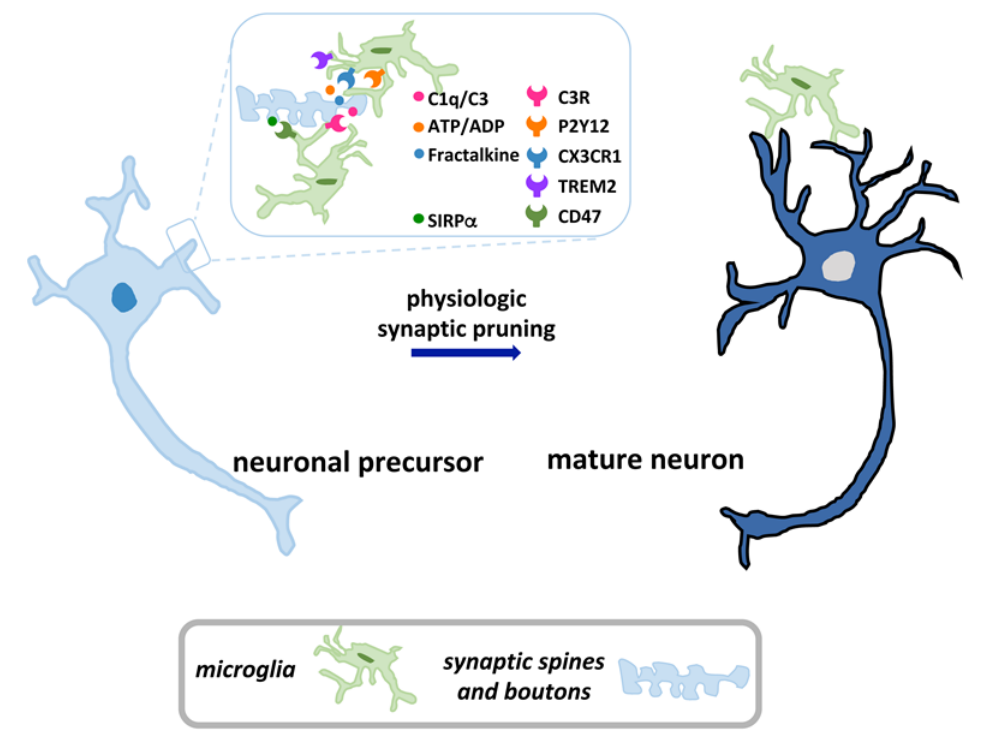
Figure 1. Physiologic synaptic pruning. During development, microglia remove excess synapses from neuronal precursors via diverse ligand-receptor mechanisms, thereby contributing to neuronal maturation.